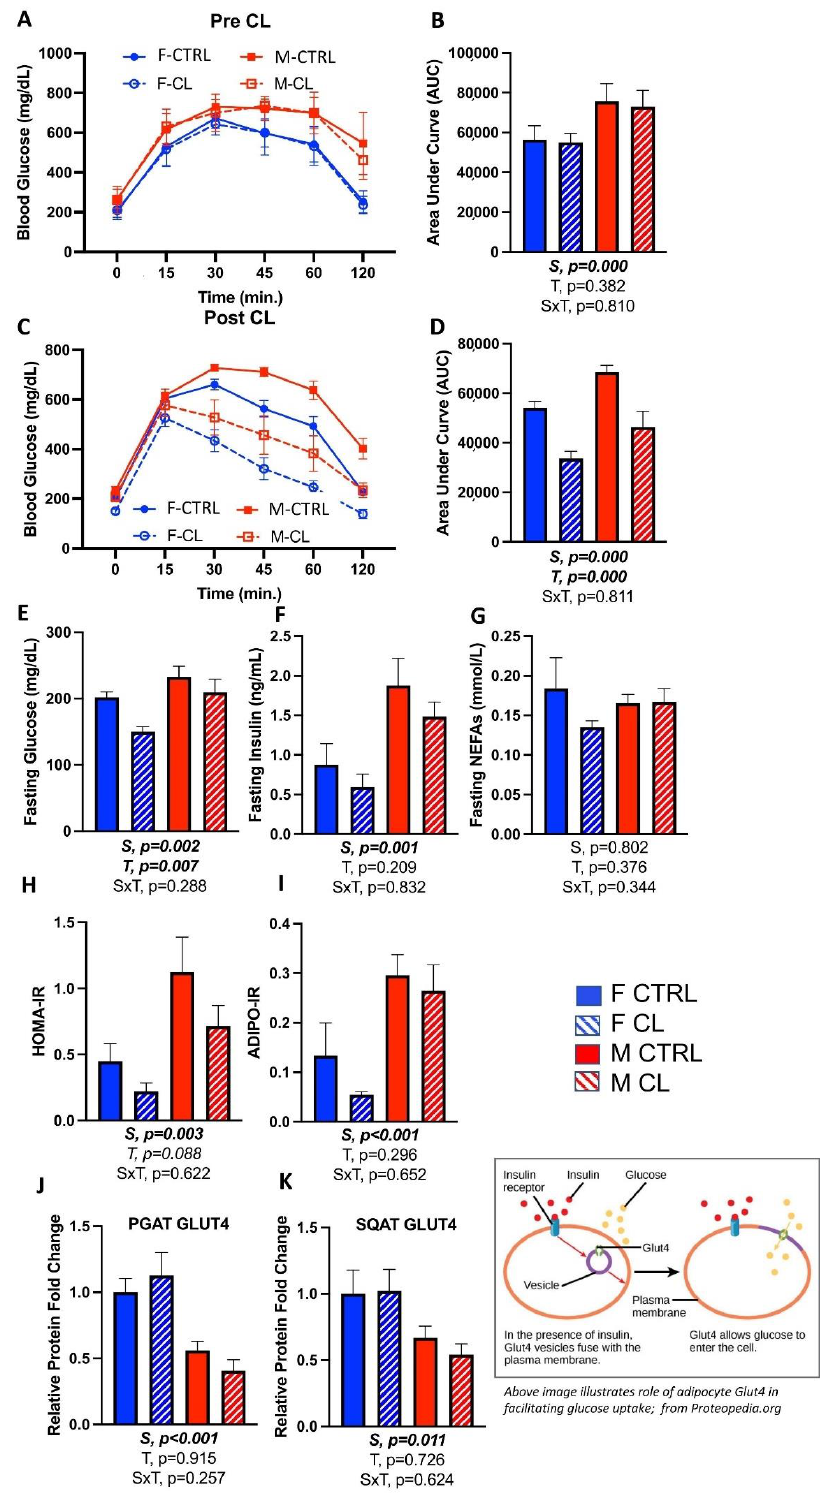
Figure 4. Male (M) and female (F) C57BL/6J mice, all on HFD, were treated for 2 weeks with daily CL injections (1 μg/g body weight) or CTRL (saline). Glucose tolerance tests (GTT) were performed and blood biomarkers were measured to assess the effect of CL on glucose homeostasis. ( A ) GTT graph before CL treatment; ( B ) area under curve (AUC) from GTT before CL; ( C ) GTT graph after CL treatment; ( D ) AUC from GTT after CL; ( E ) fasting blood glucose; ( F ) fasting blood insulin; ( G ) fasting blood non-esterified fatty acids (NEFAs); ( H ) Homeostatic Model Assessment for